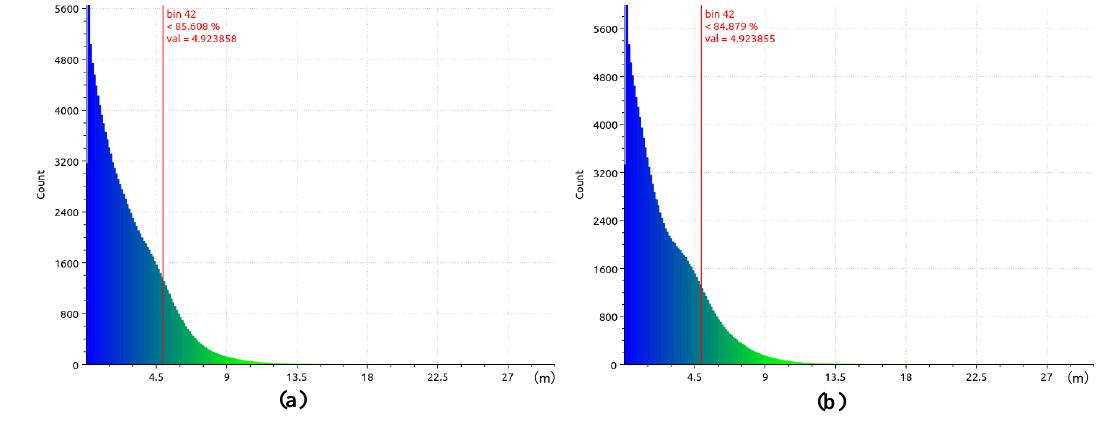
Figure 18. The histogram statistics of the different methods on the data of Mountains-2 ( a ) and Mixed Zone-2 ( b ). Table 4. Time cost compare on datasets in Table 3, T is the Town, M is the Mountains, and MZ is the Mixed Zone.